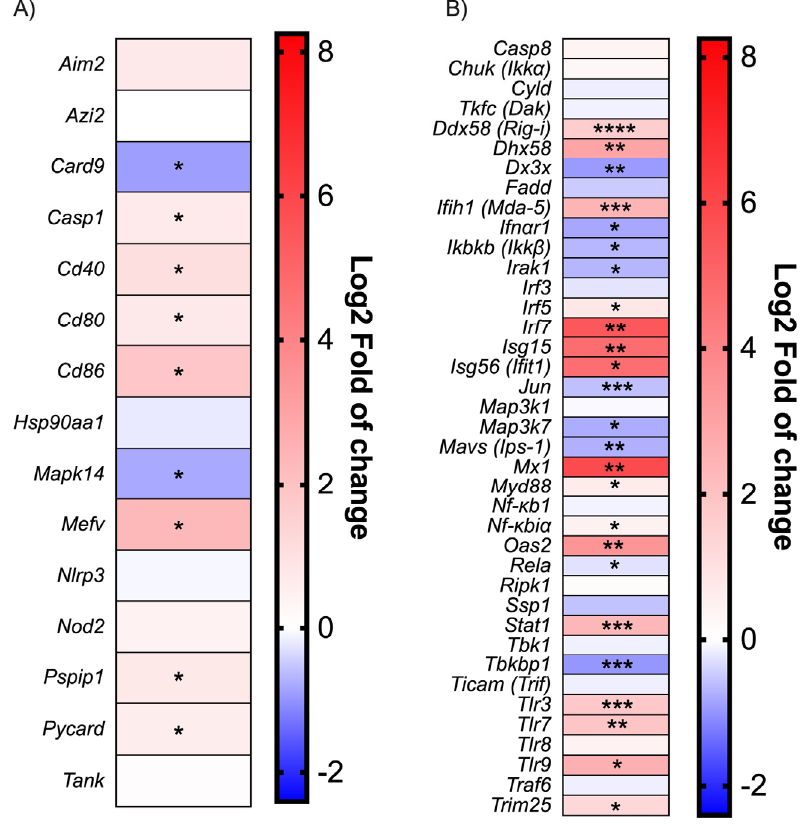
Figure 2. Antiviral response gene expression following infection with Wuhan strain. Heat map representation of cytokines and inflammatory-related genes ( A ) and Type I IFN production and signalization-related genes ( B ). Results are expressed as fold (log 2 ) relative to mock-infected mice (mean, n = 4/group). For gene expression, statistical analyses were performed by comparing 2 ( −Δ Ct) values for each gene in the control group and infected groups with a nonparametric t -test. * p < 0.05, ** p < 0.01, *** p < 0.001, **** p < 0.0001.